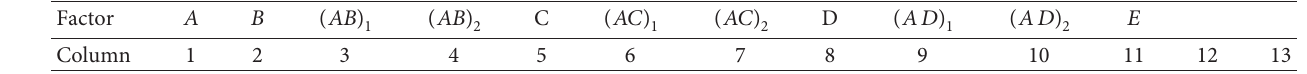
Table 7: The table of variance analysis of skidding’s safety margin M